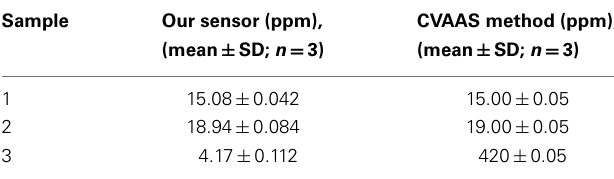
Table 3 | Comparison of Hg 2 + content determined by using po-Gr/PEDOT:PSS/GCE and by standard cold vapor atomic absorption spectroscopy (CVAAs) method in unknown samples .